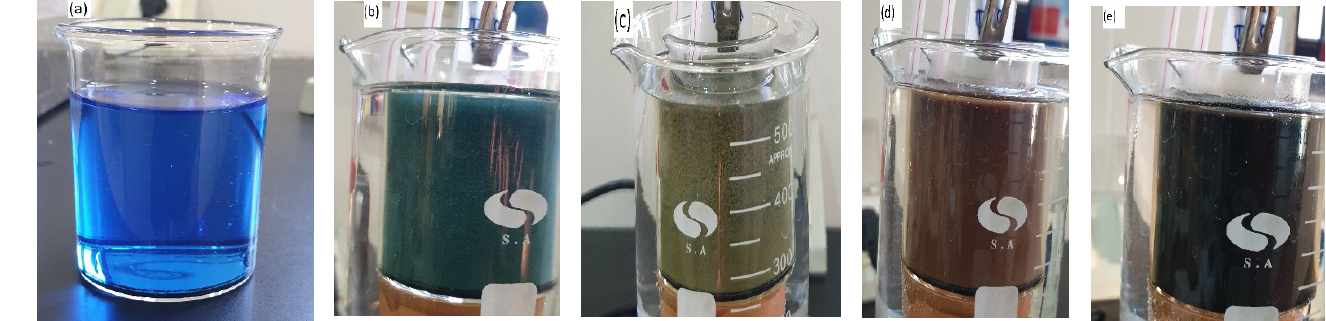
Figure 1. The stages of chemical bath deposition of Cu 2 S: ( a ) 0 min, ( b ) after 2 min, ( c ) 3 min, ( d ) 5 min, and ( e ) 6.5 min with CuSO 4 . 5 H 2 O = 3 M, SC (NH 2 ) 2 = 1 M, bath temperature = 70 °C, and pH = 10.